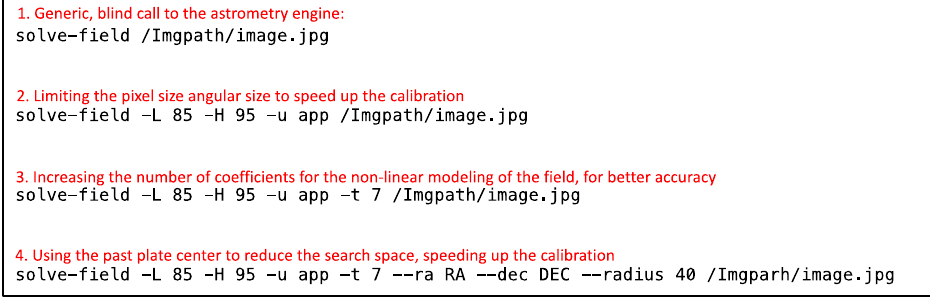
Figure 15. Using the astrometry engine for obtaining the calibration between pixels and angular coordinates.